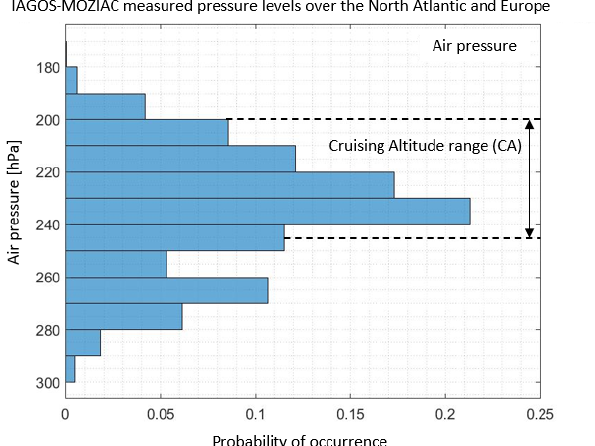
Figure 2. Occurrence fractions of passenger aircraft flight levels in pressure (unit: hPa) measured during the IAGOS-MOZAIC pe- riod (1996–2010) over the North Atlantic and Europe. The pressure range 200–245hPa between the dashed lines is adopted as the most frequent aircraft cruising altitude (CA) range (see text for the deter- mination of the boundary pressure